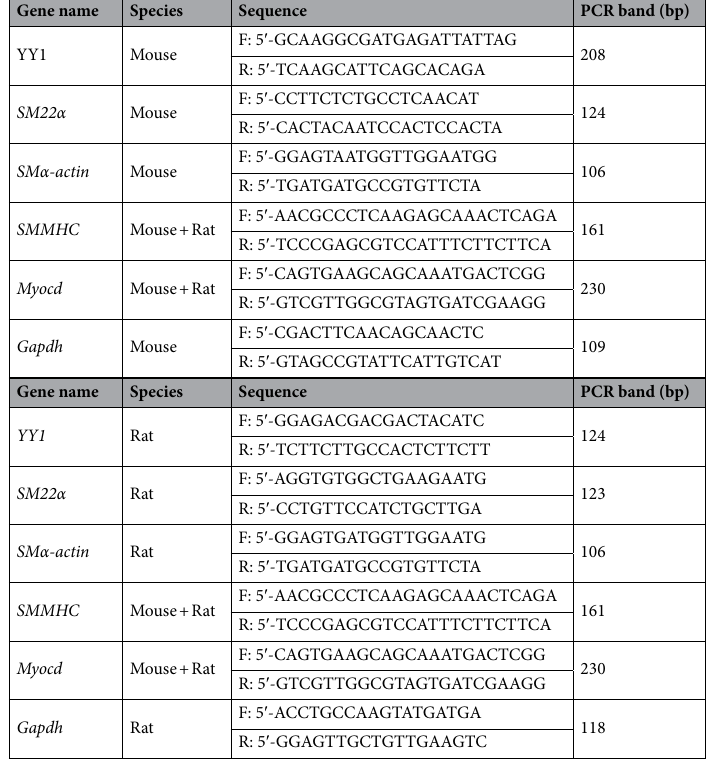
Table 1. Primer sequences for qPCR